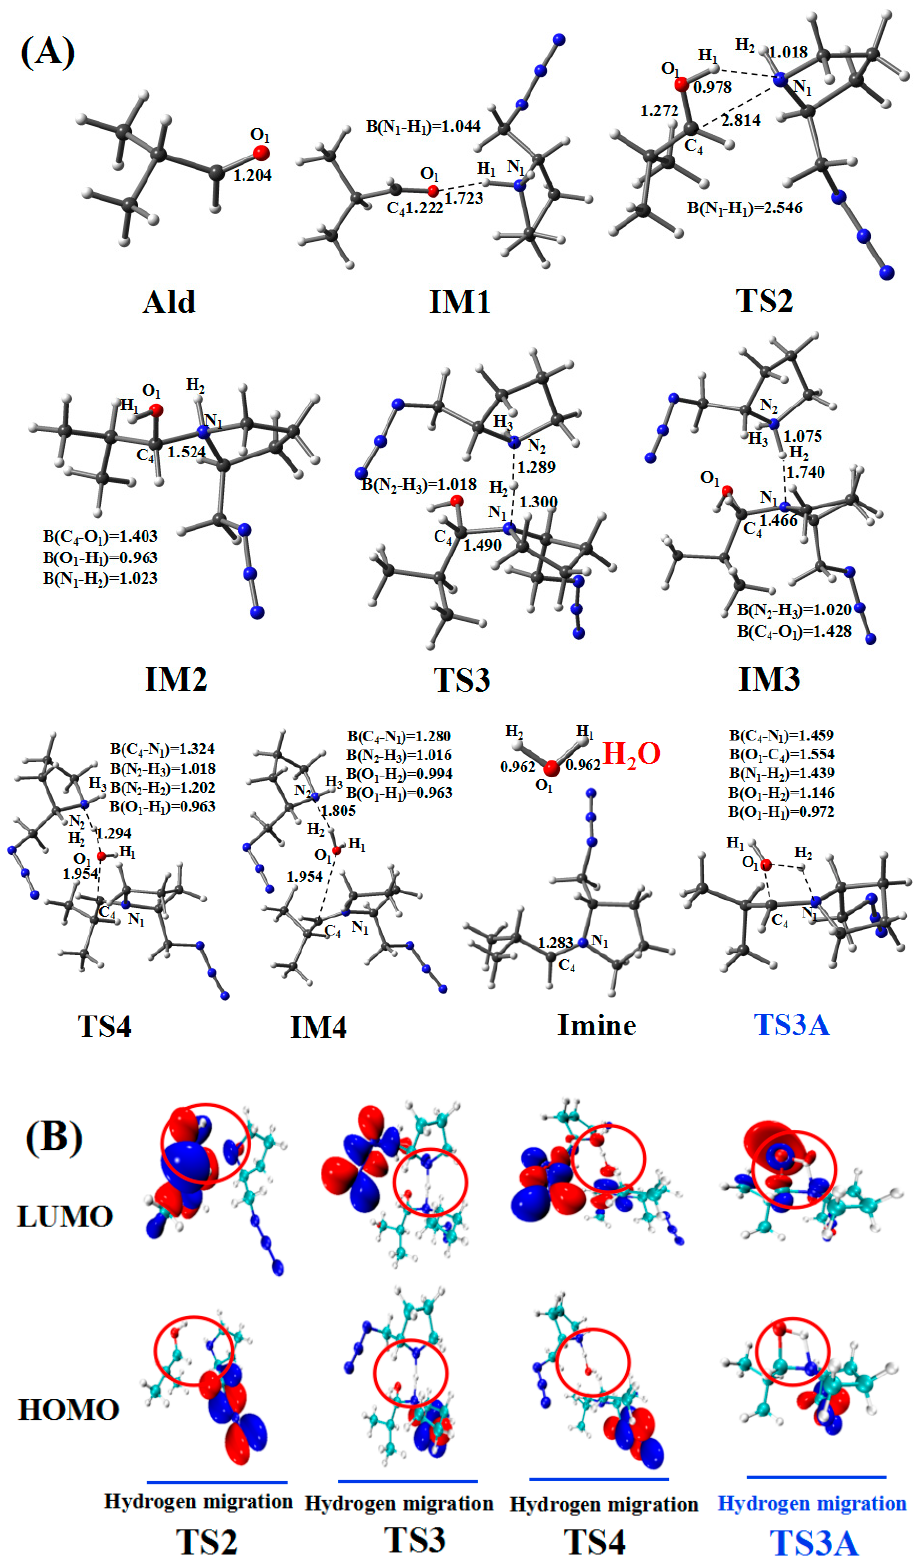
Figure 6. ( A ) Optimized geometries for the amine–aldehyde condensation reaction pathway; the critical bond lengths are in Å. ( B ) Frontier orbitals of TS2, TS3, TS4, and TS3A.